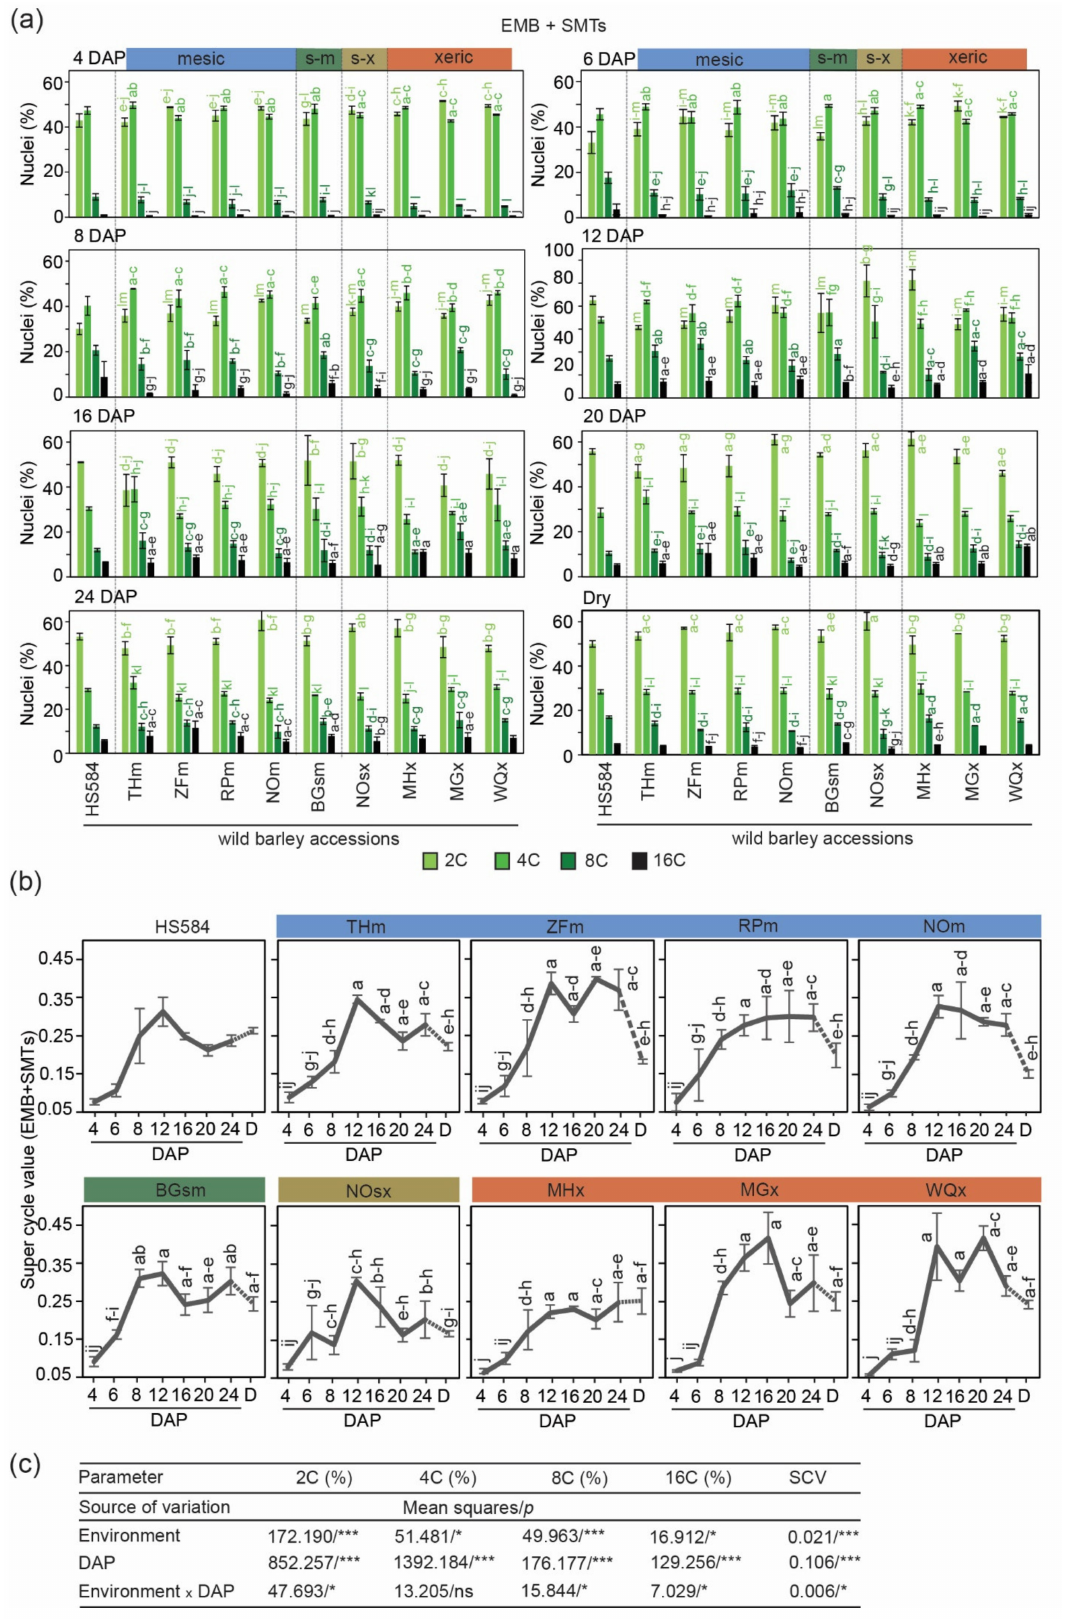
Figure 3. Estimation of C-values in diploid seed tissues represented by the embryo (EMB) and seed maternal tissues (SMTs) of ten wild barley accessions originating from Israel. ( a ) Percentage of 2C, 4C, 8C and 16C nuclei at a given day after